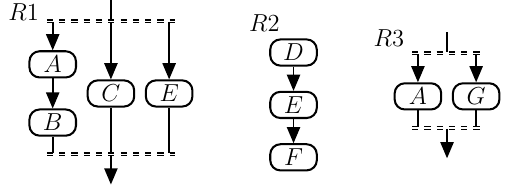
Figure 4. Arbitrary order dependencies for resource allocation in Example 1.